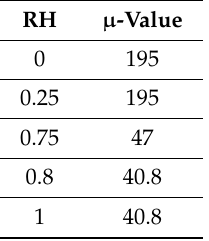
Table A15. Water vapor di ff usion resistance factor—improved model.